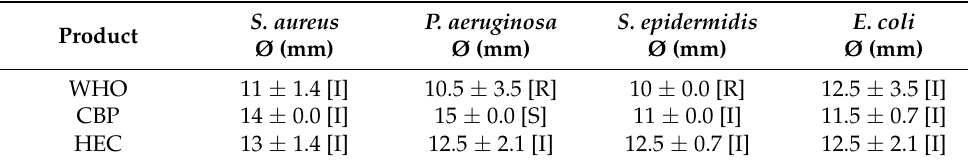
Table 7. Agar diffusion test for the antimicrobial evaluation of the formulation with hydroxyethyl- cellulose (HEC), the formulation with carbopol (CBP), and for formulation 1—WHO against the selected strains Staphylococcus aureus (ATCC 6538), Pseudomonas aeruginosa (ATCC 9027), Staphylococ- cus epidermidis (ATCC 12228) and Escherichia coli (ATCC 87394). Data are presented as average and standard deviation (SD) of the diameters (Ø) measured (n = 2; r = 2). Ø ≤ 10 Resistant [R]; 11 ≥ Ø ≤ 14 Intermediate [I]; Ø ≥ 15 Sensitive [S].